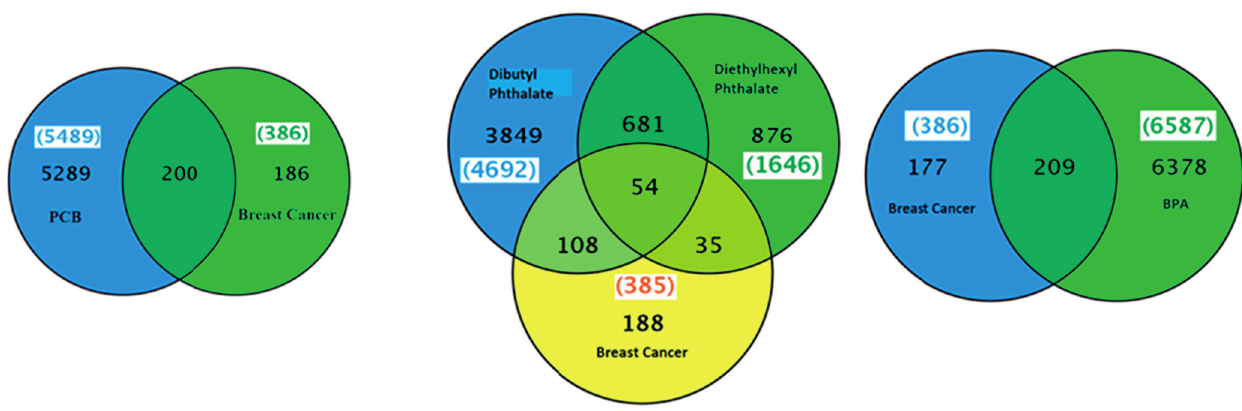
Figure 3. A Venn diagram of list of genes common between breast neoplasms and PCBs, phthalates or bisphenol